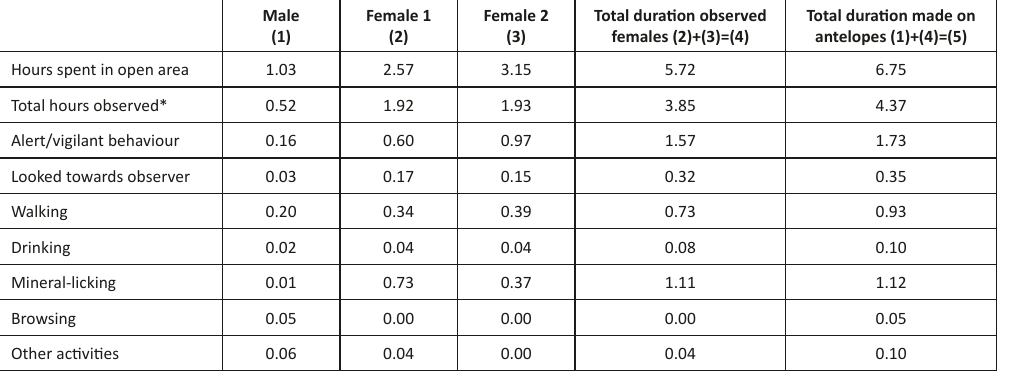
Table 1. Summary of activity duration (in hours) recorded for two females and one male Four-horned Antelope in Bardia National Park, Nepal from 15–18 May